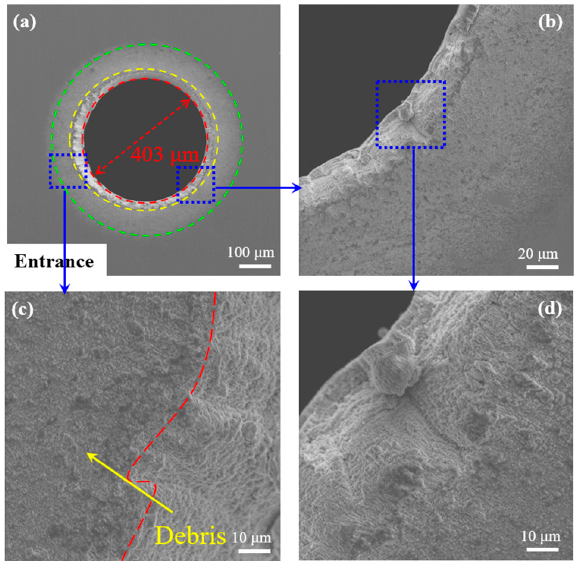
Figure 12. Enlarged view of the 3-1-3-5-2-4 entrance hole morphology micro area ( a ) entrance hole; ( b – d ) enlarged view.